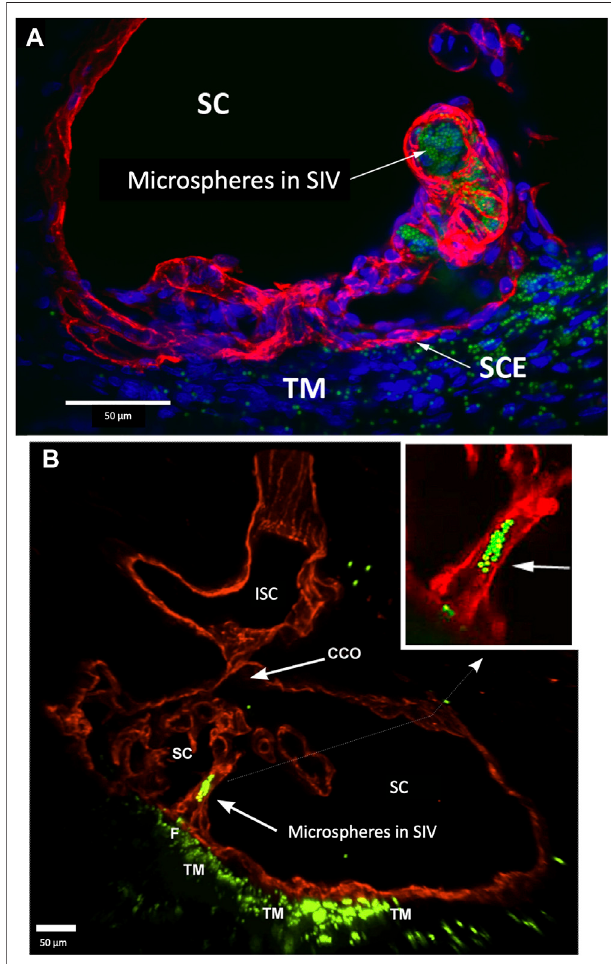
FIGURE 8 | Perfused fl uorescent microspheres enter the trabecular meshwork and a Schlemm ’ s canal inlet valve-like structure originating from Schlemm ’ scanal endothelium. (A) Merged CD31 (red), DAPI (blue), and 1-µm fl uorescent microsphere (green) channels. The stack size is 60 µm. Schlemm ’ s canal (SC) inner wall endothelium forms a valve-like structure (SIV) oriented circumferentially in SC, permitting identi fi cation of a cross section through its diameter; fl uorescent microspheres fi ll the SIV lumen. (B) Merged CD31 (red) and 1-µm fl uorescent microsphere (green) channels. The stack size is 84 µm. The funnel-shaped con fi guration (F) at an SIV entrance extends intoSCtoformacylindricalconduitattachingtostructuresarisingfromtheSC externalwall.TheSIVcontainsmicrospheres,whichweremademoreobvious in the inset image. A collector channel (CC) and its ostia (CCO) are apparent. Fluorescentmicrospheresarepresentinthetrabecularmeshwork(TM)inboth (A) and (B) (A) #29RIN8; (B)